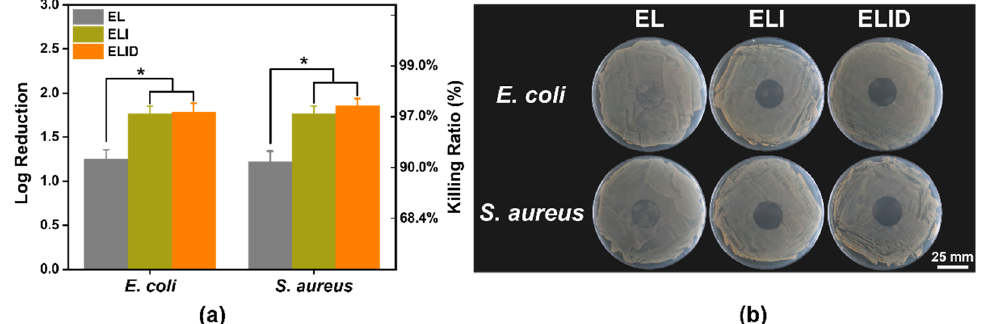
Figure 3. ( a ) In vitro antibacterial efficiency of EL, ELI, and ELID (PBS as blank); ( b ) contact-active antimicrobial activity ( E. coli and S. aureus ) of hydrogels ( n = 4, * means p ≤ 0.05).